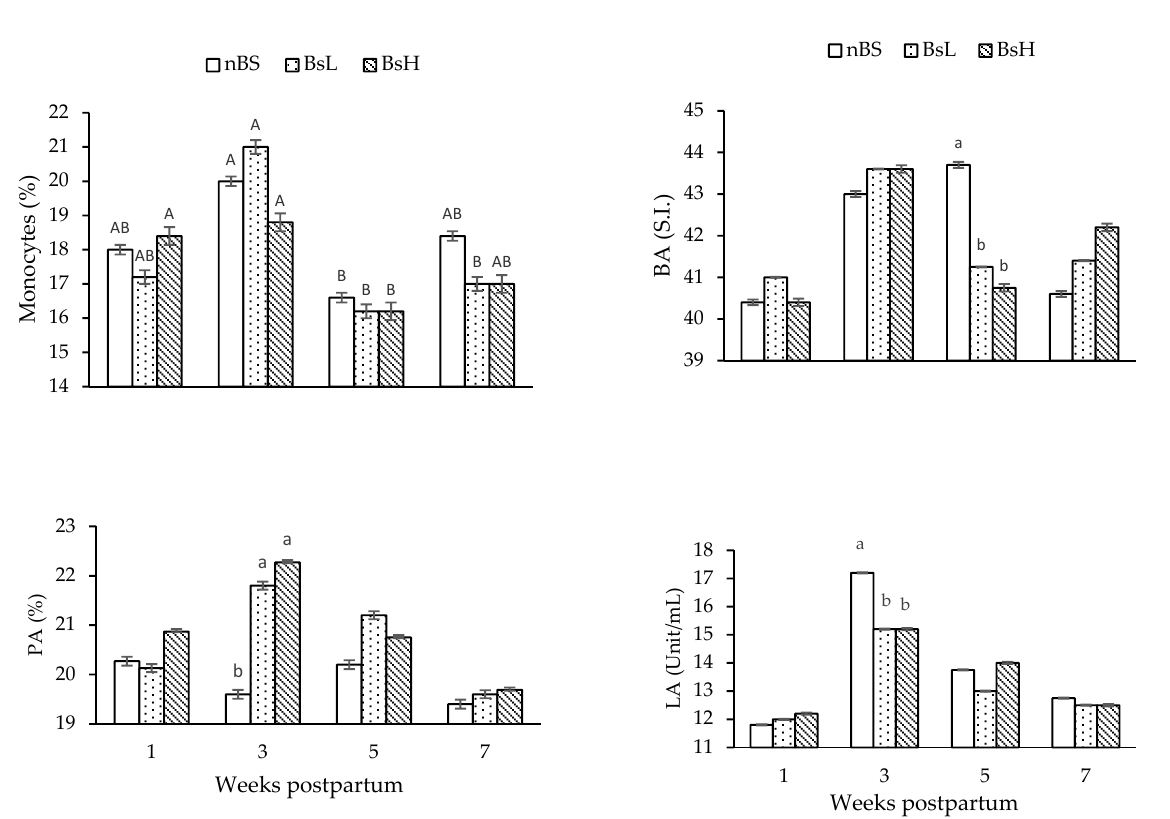
Figure 1. Treatment by time interaction (means ± SEM) effects on the percentage of monocytes, bactericidal activity (BA), phagocytic activity (PA), and lysozyme activity (LA) of transitioning goats that received 0 (nBS), 2 (BsL), and 4 (BsH) g of Boswellia sacra resin daily from week 2 prepartum to week 7 postpartum. Means within the same time period having different superscripts (a, b) differ significantly ( p < 0.05) and means within the same treatment having different superscripts (A, B) differ significantly ( p < 0.05).